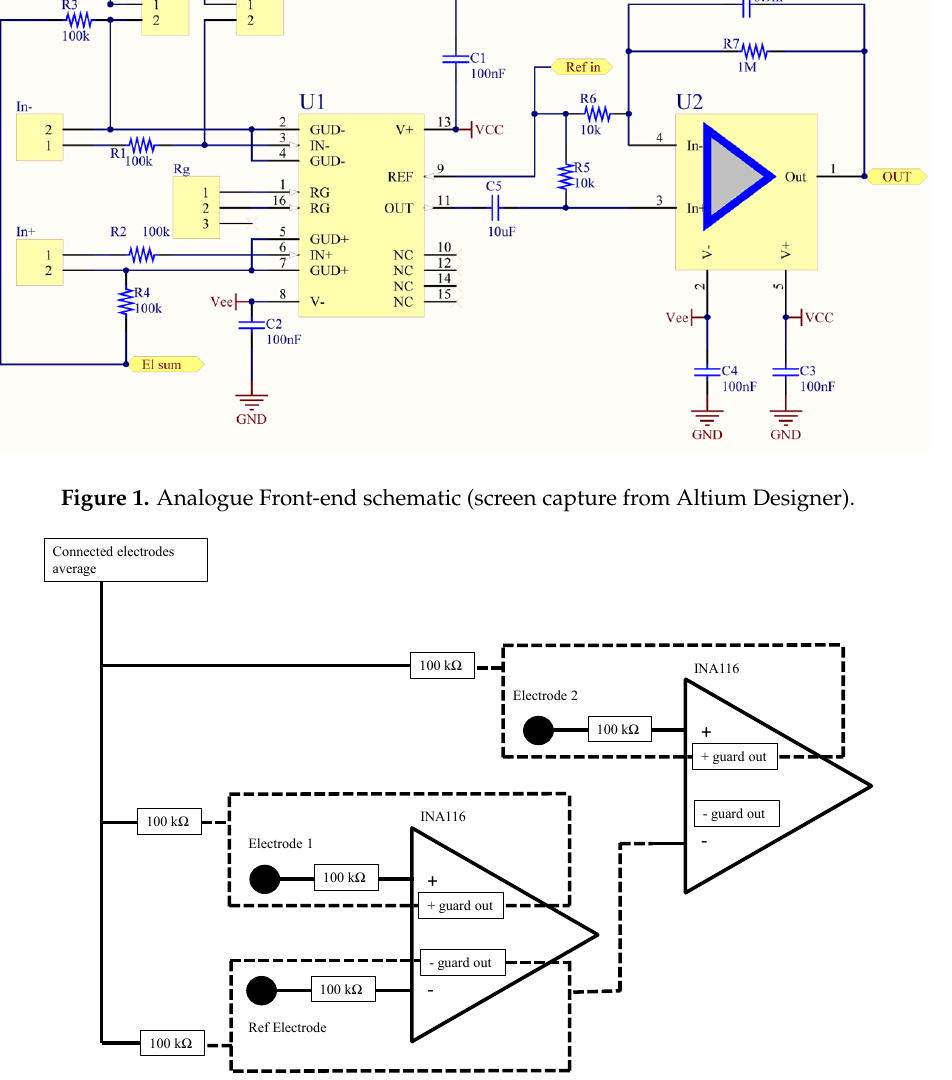
Figure 2. Reference replication, limited to two channels (see